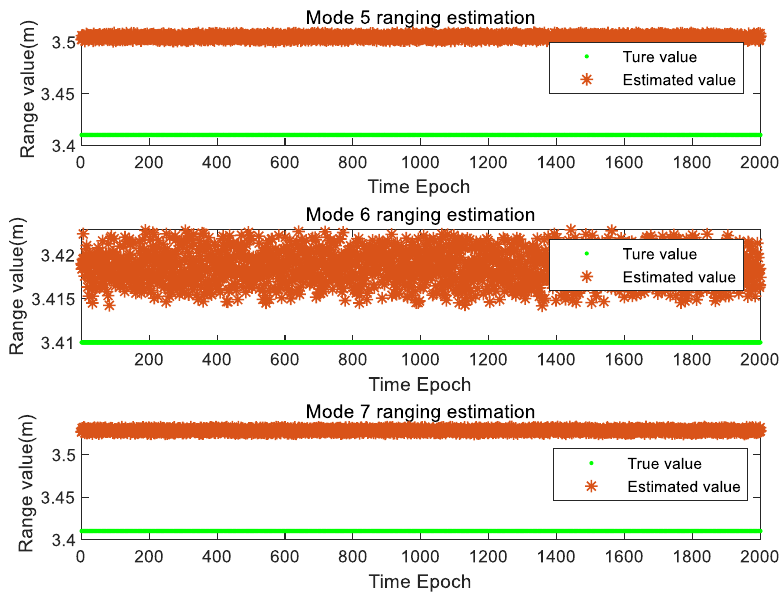
Figure 10. Ranging accuracy under different three-frequency combination modes.